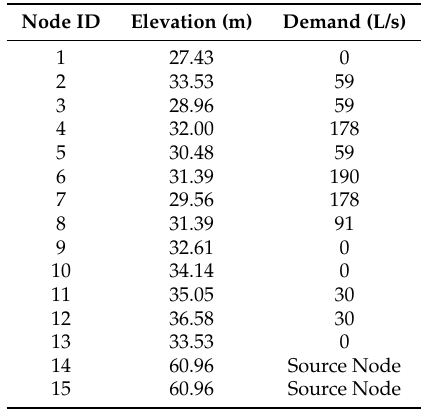
Table A2. Node data for the case study network 1 [31].